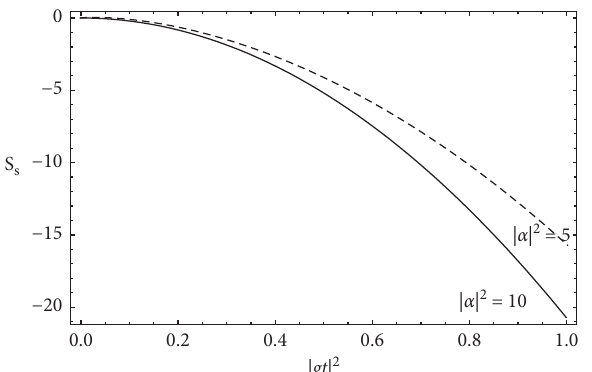
Figure 2: Variation of the sum squeezing S